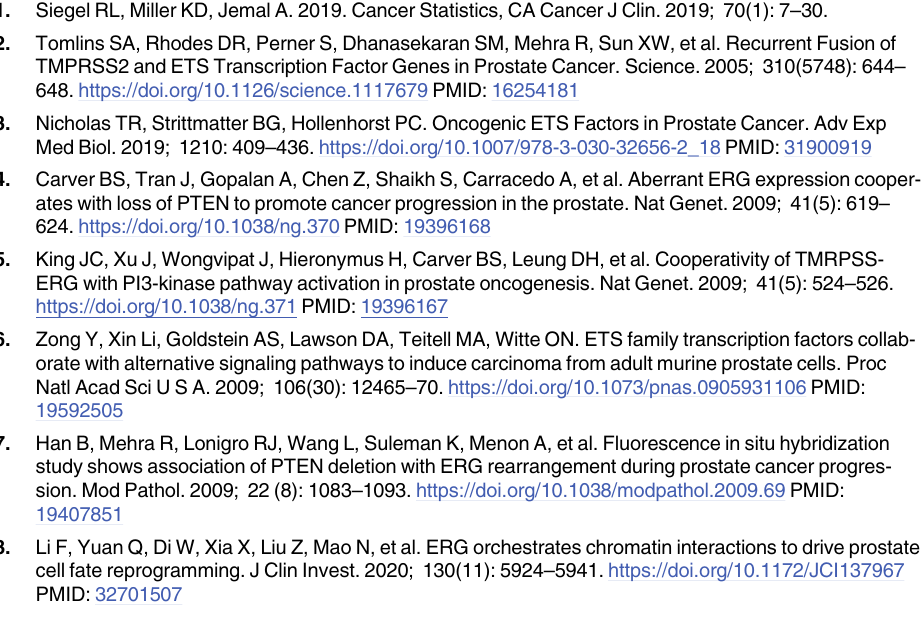
unique (blue). (D) Gene tracks of ERG ChIP-Seq in VCaP cells treated with vehile (red) or LY294002 (blue). S5 Fig. Active PI3K/AKT signaling alters the ERG transcriptome. Heatmap Comparison of RNA-Seq data depicting significantly differentially regulated genes between the RWPE1 cell lines